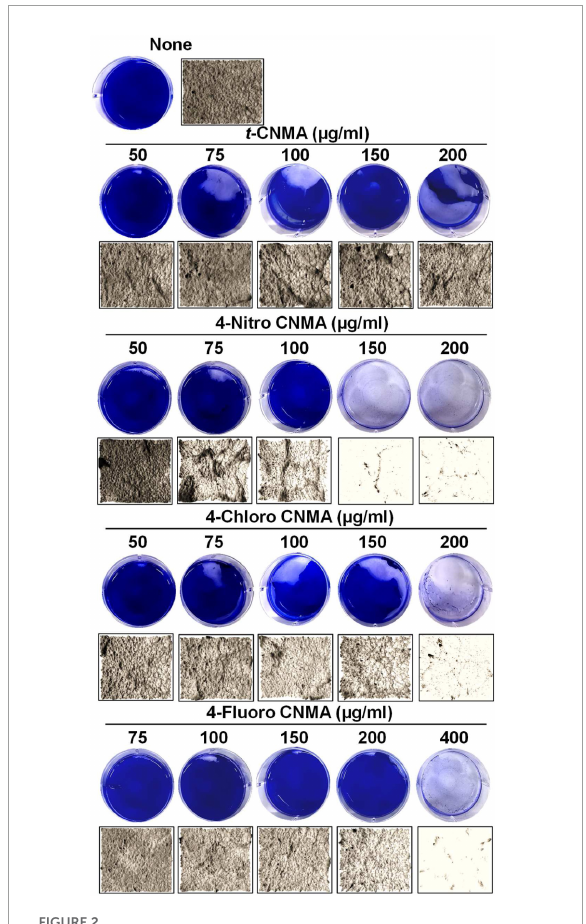
FIGURE2 Inhibition of A. tumefaciens biofilm formation on flat polystyrene in 6-well plates as determined by crystal violet staining (A) and optical microscopy at 20 × magnification (B) by t -CNMA, 4-nitro CNMA, 4-chloro CNMA, and 4-fluoro CNMA in the concentration range (50–400 µ